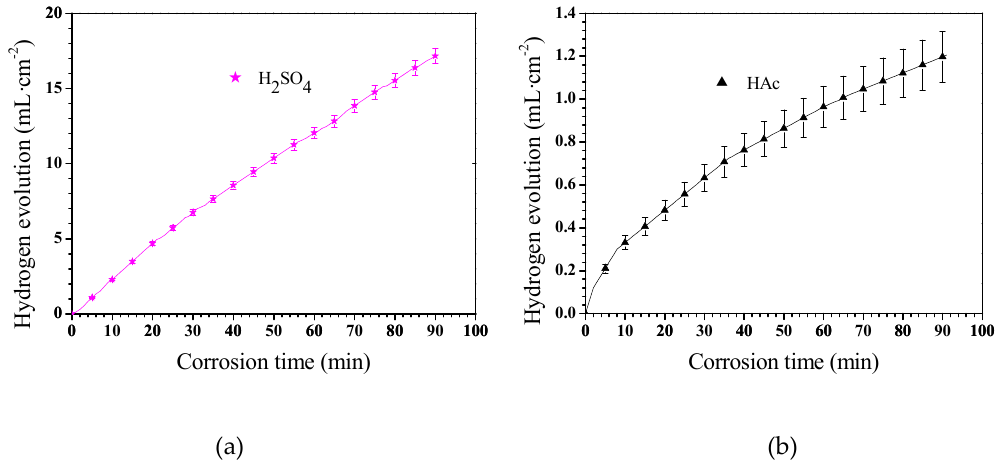
Figure 5. The Mg–Al alloy's hydrogen evolutions in H 2 SO 4 ( a )and HAc ( b )solutions for 90 min.